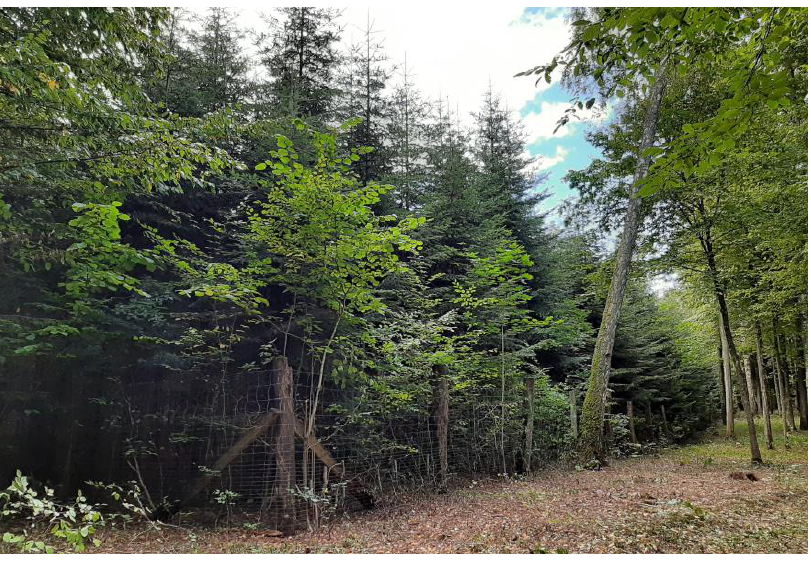
Figure 1. Plot No. 1 of a half- sib silver fir plantation (photo by M. Kaczyński).